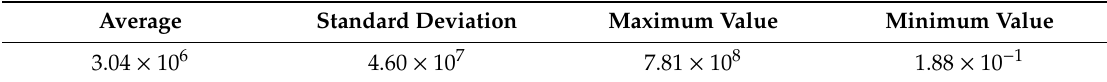
Table 2. Statistics of the well-loss coe ffi cient